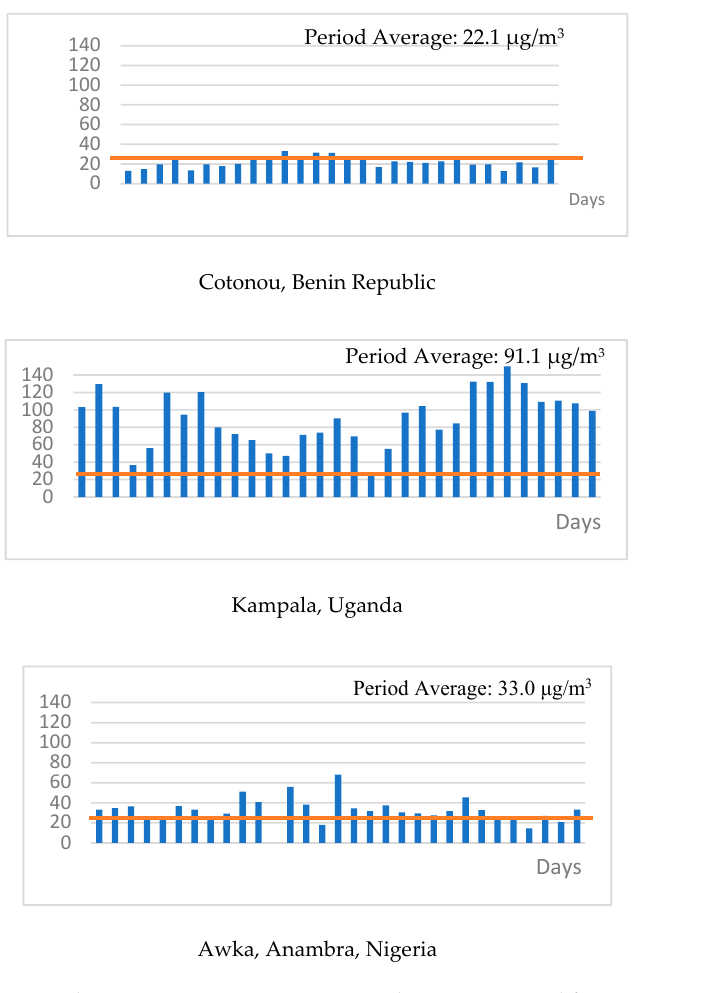
Figure 2. Daily average PM 2.5 concentrations by site measured from 1st to 31st July 2019 in the MA3 pilot study. Y-axis represent PM 2.5 concentrations in µg/m 3.